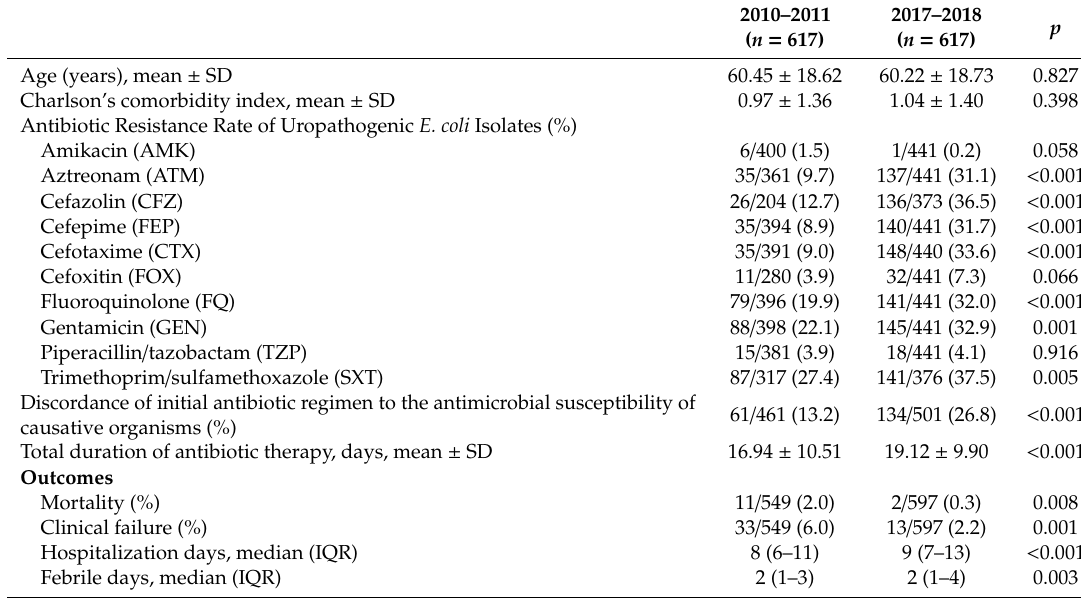
Table 5. Comparison of clinical and microbiological characteristics of patients with community-acquired acute pyelonephritis after propensity-score